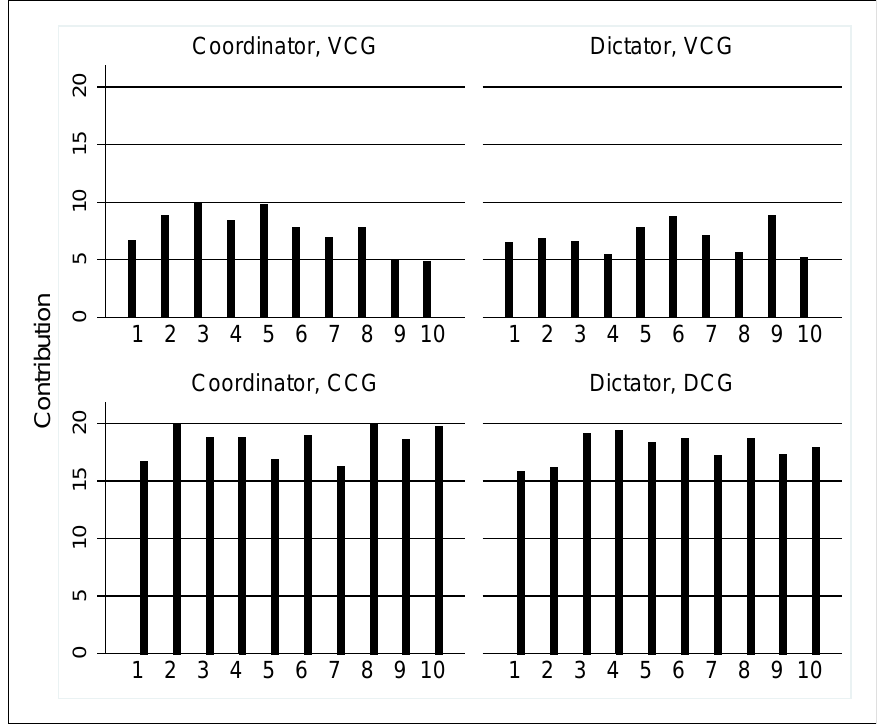
Figure 3. Contributions. Mean period contributions by treatment and group. The data of rounds 1 and 2 are